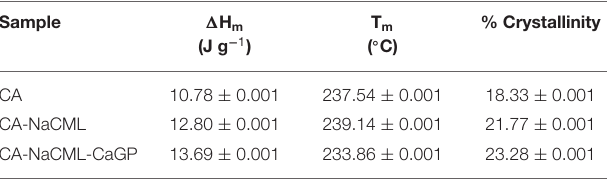
TABLE 3 | Influence of the additives on the values of 1 H m , T m and percentage of crystallinity for the